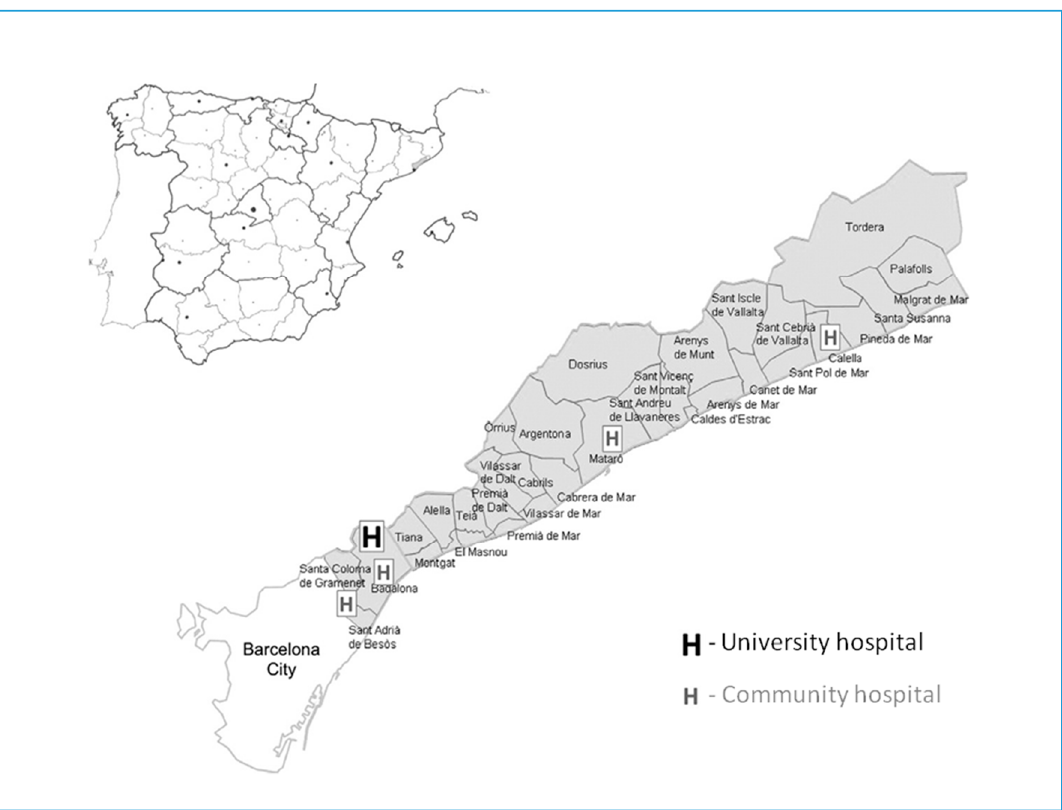
Figure 1. Geographical distribution of the Ruti-STEMI-Shock population-based registry in the northern Barcelona metro area.